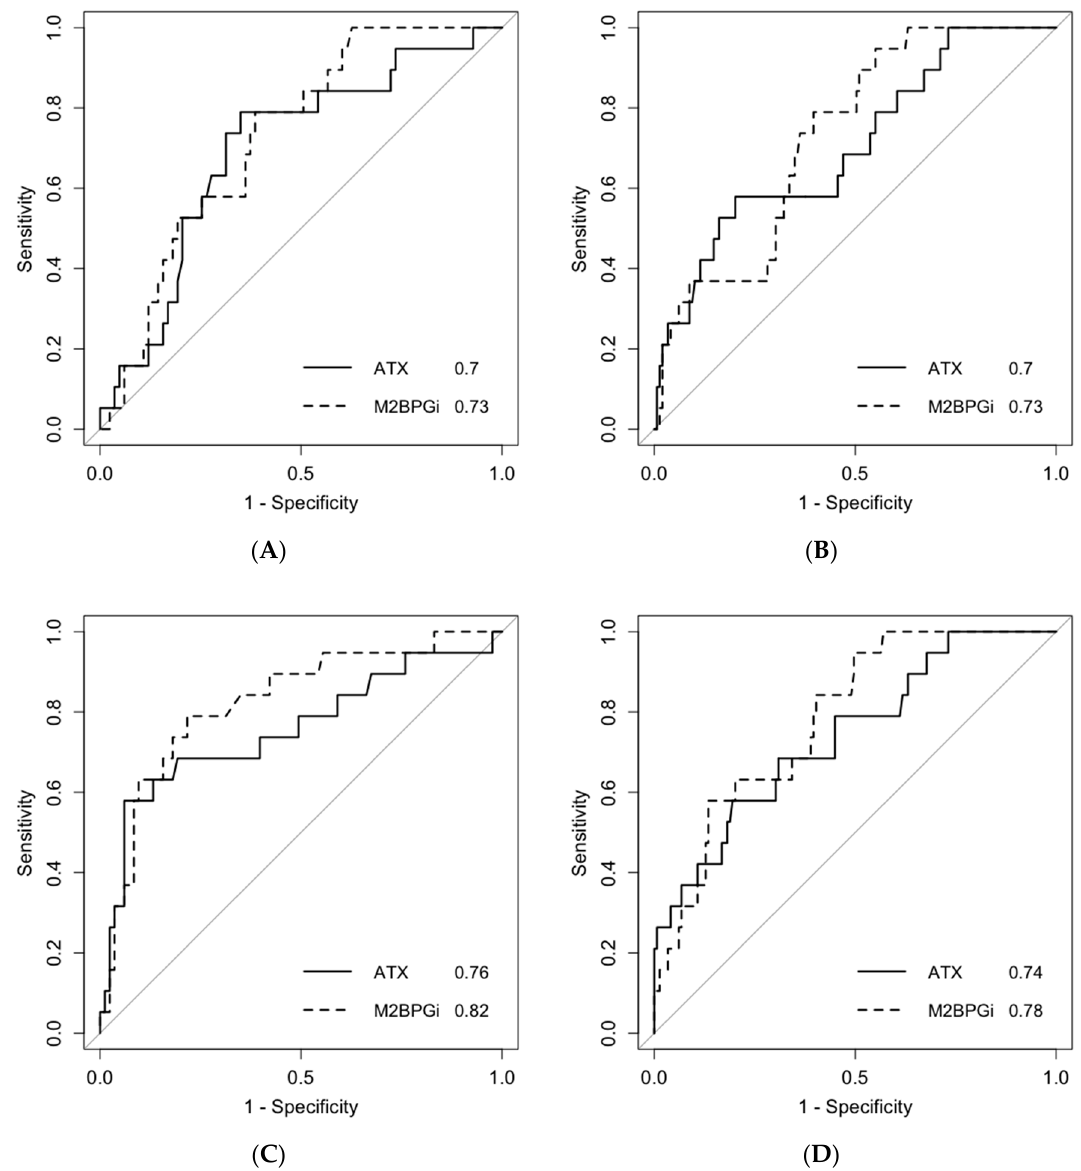
Figure 4. Area under the receiver operating characteristic curves for predicting post-SVR HCC development. Data from Cohort B were used for the analysis. Data from male patients ( A , C ) and female patients ( B , D ) are shown. A and B indicate pretreatment levels, and C and D indicate those at 12 / 24 weeks after antiviral treatment. The numbers at the bottom right are the area under the receiver operating characteristic of each liver fibrosis marker. SVR: sustained viral response; HCC: hepatocellular carcinoma; ATX: autotaxin; M2BPGi: Wisteria floribunda agglutinin positive Mac-2 binding protein.